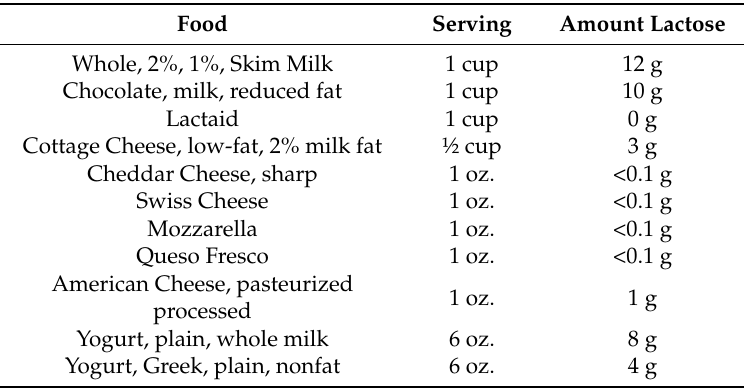
Table 4. Lactose in common dairy food